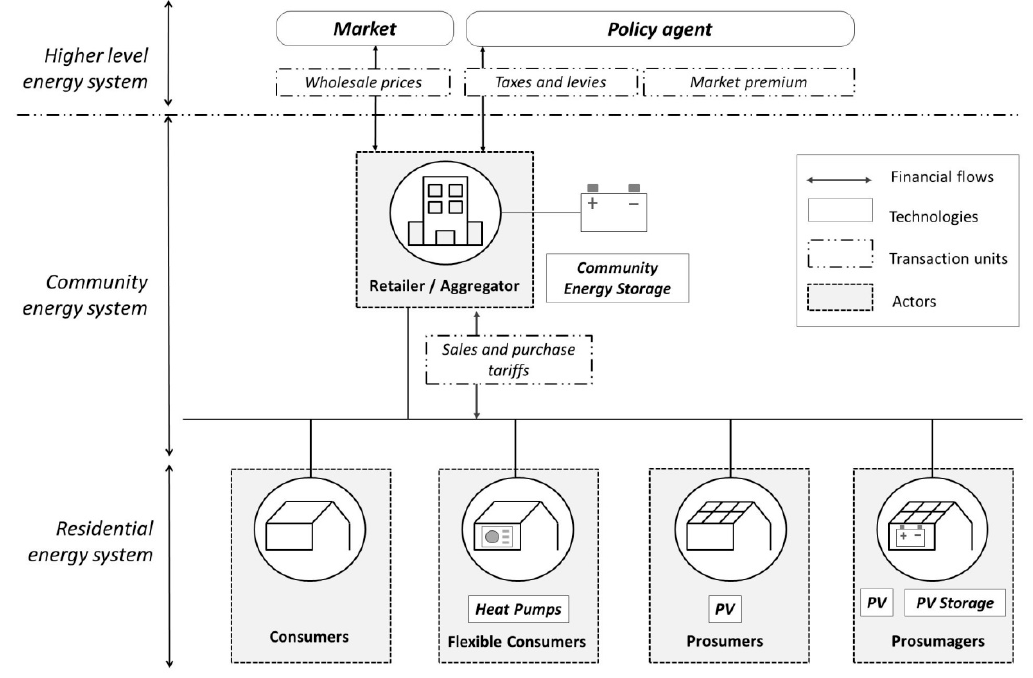
Figure 2. Schematic overview of the community energy system model.